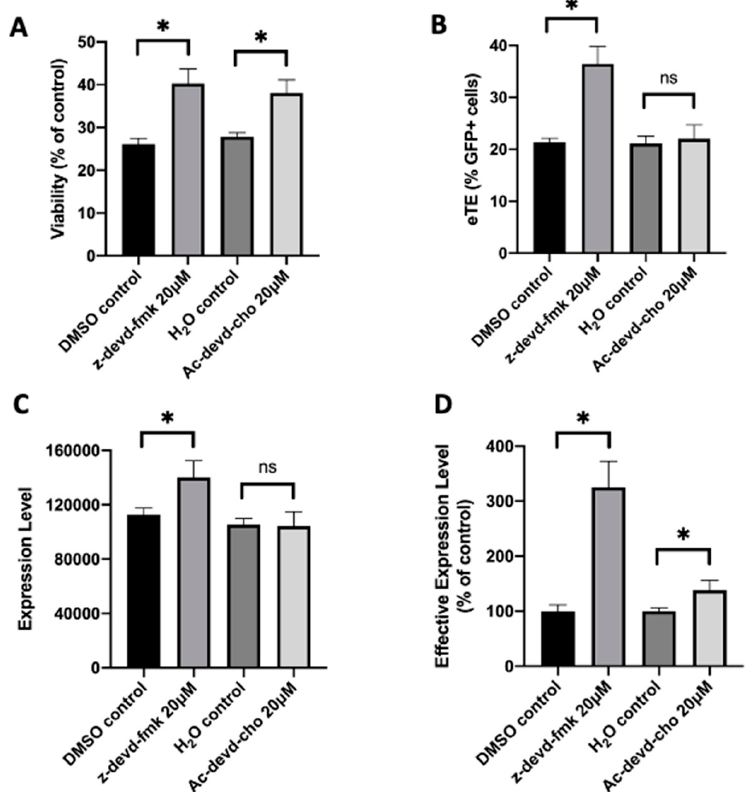
Figure 8. Effects of caspase inhibitors on cell viability and EGFP expression in human primary T cells. The experimental condition was similar to that in Figure 1, except that human primary T cells instead of Jurkat cells were used in the experiment, and that z-devd-fmk and Ac-devd-cho, instead of z-vad-fmk, were used to inhibit cell apoptosis. ( A ) Cell viability; ( B ) eTE; ( C ) expression level; ( D ) effective expression level. Pulsing condition: 650 V/0.2 cm, 400 µs, 1 pulse. ns, non-significant. Error bars, SEM; * p < 0.05, Student’s t -test. N = 4.